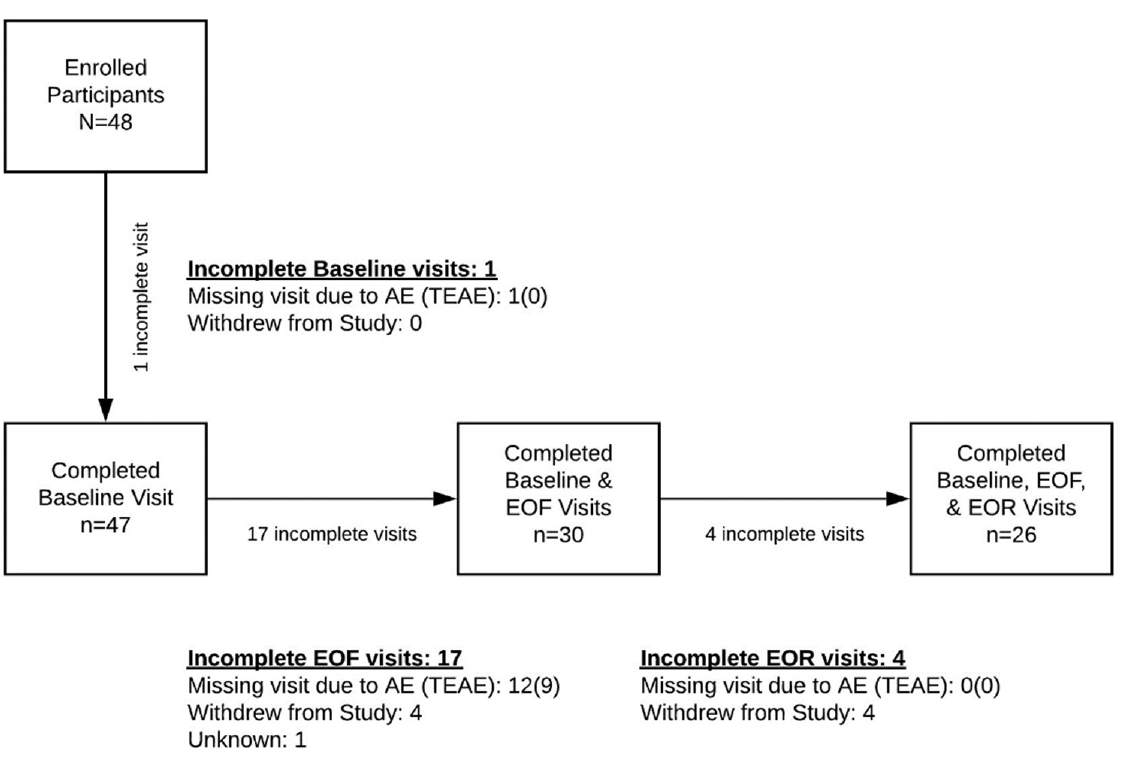
Figure 1. Enrollment diagram. EOF, end of fast; EOR, end of refeed; AE, adverse event; TEAE, treatment emergent adverse event. See Results Section 3.1 for a list of AEs. Table 1. The effects of fasting and refeeding on cardiometabolic